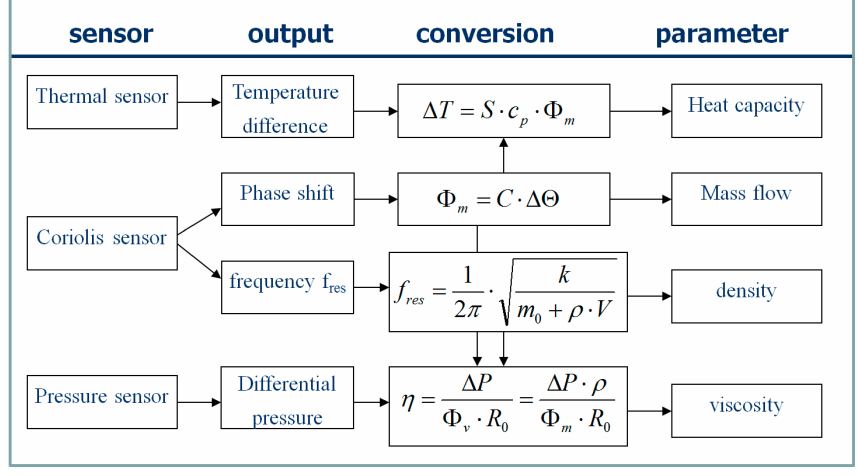
Figure 1. Schematic of the sensors, their relations and their transfer